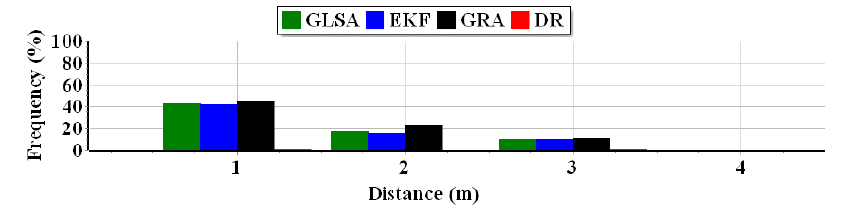
Figure 13. Percentage of distance to the reference position from the estimated position during a single crossing of the SV.